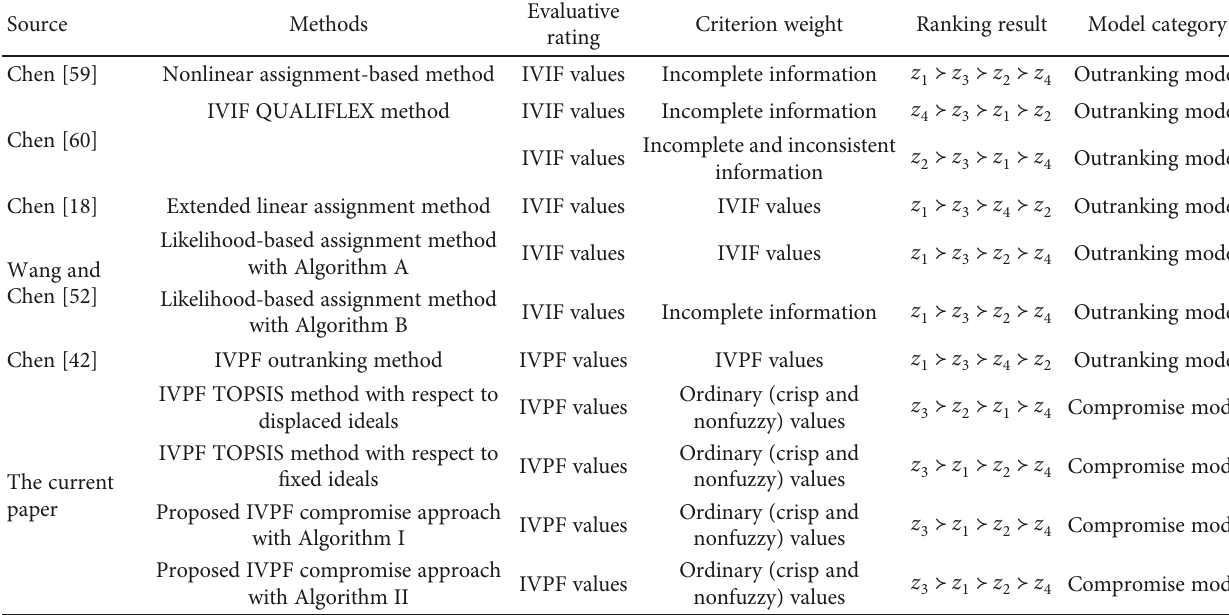
Table 3: Comparative analysis of the obtained results in the bridge construction